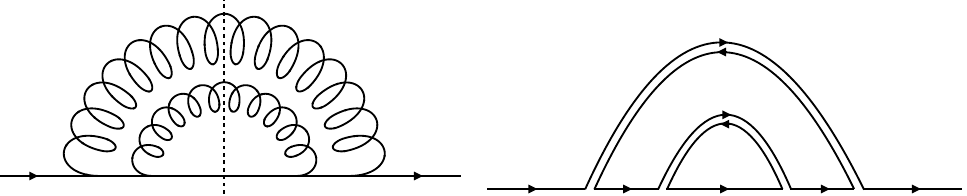
Figure 2: Graphical representation of uncorrelated two-gluon emission in the collinear limit from a quark. Left: An example Feynman diagram for the squared amplitude, with the dashed vertical line representing the cut that exposes the final state particles. Right: The corresponding birdtrack diagram that tracks the flow of color amongst the particles.